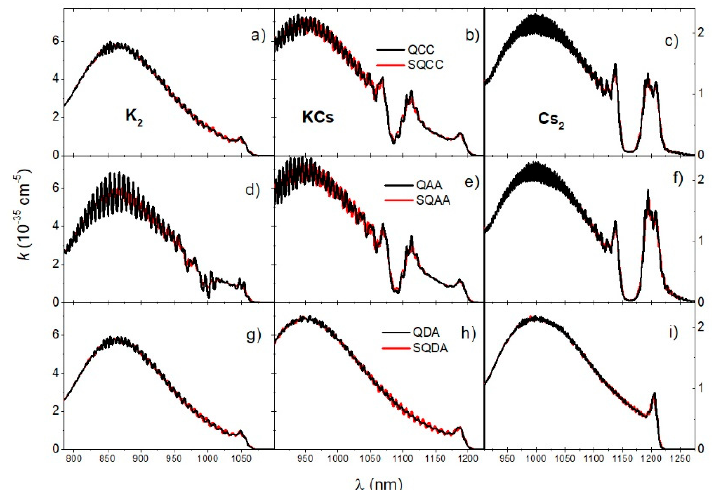
Figure 6. Reduced absorption coe ffi cients of K 2 , KCs, and Cs 2 molecules at temperature T = 700 K are shown in the first ( a , d , g ), second ( b , e , h ), and third columns ( c , f , i ), respectively. The first row ( a – c ) shows the QCC and SQCC spectra, the second row ( d – f ) shows the QAA and SQAA spectra, and the last row ( g , h , i ) shows the QDA and SQDA spectra.